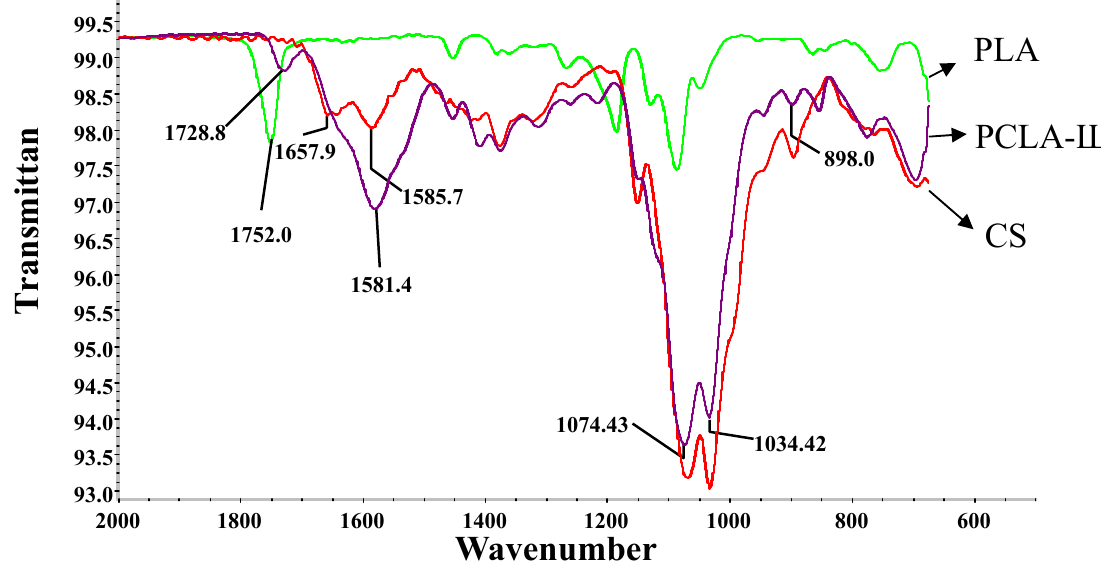
Figure 1. IR spectra of CS, PLA and PCLA-III (LA: CS = 4:1, w/w)